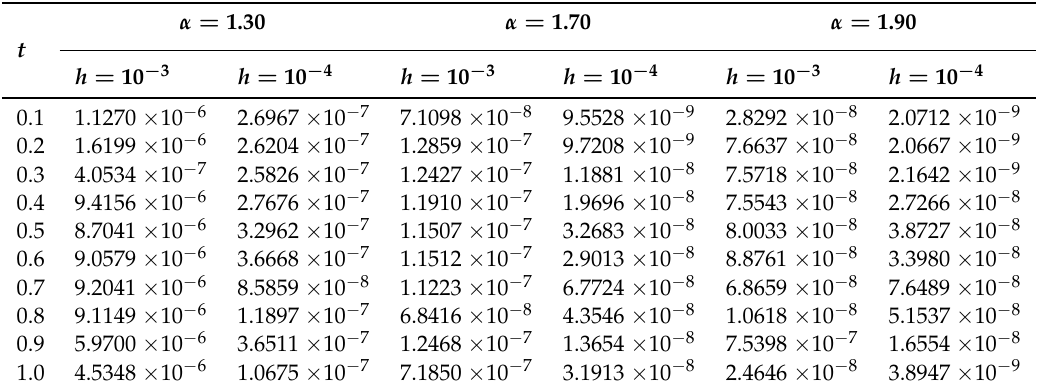
Table 6. Absolute error at each point, t when solving Example 3 by using FEAM3 for different step size, h and 1 < α < 2.